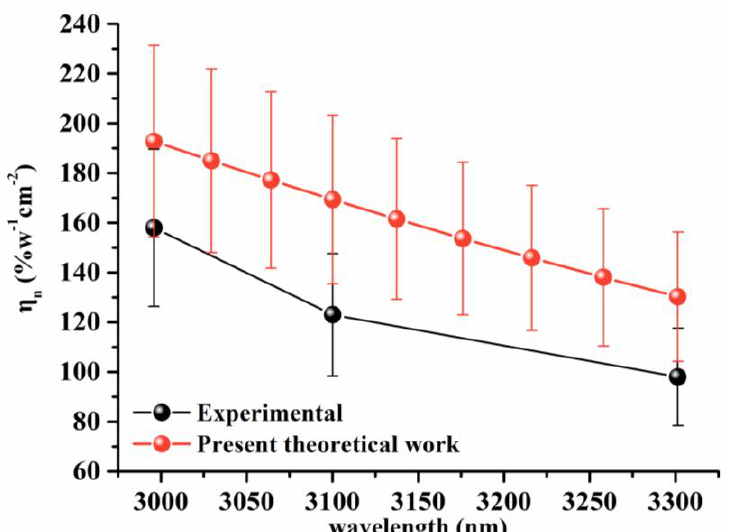
Figure 6. A comparison of the calculated (red balls) and experimental (black balls) results [17] of normalized nonlinear conversion efficiency η n .